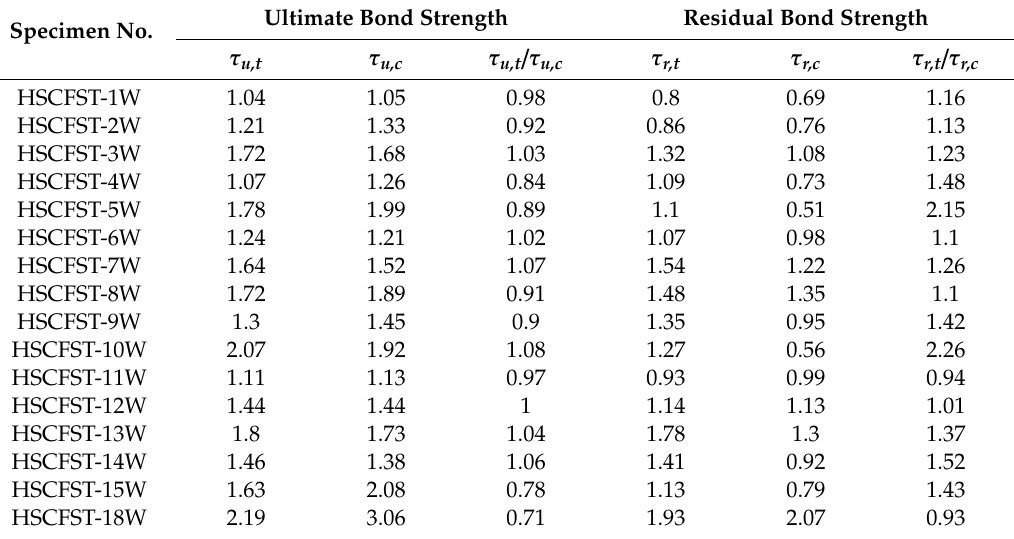
Table 8. Comparison between calculations and experimental